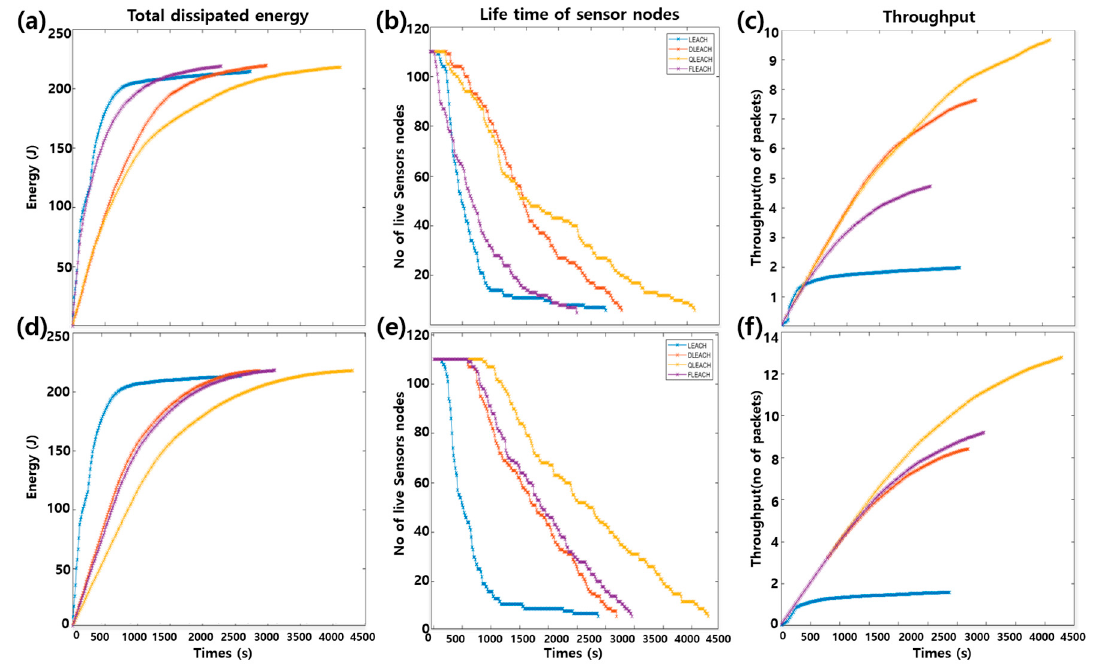
Figure 9. LEACH results on energy loss, number of alive nodes, throughput. ( a – c ) is the result from dynamic topology model and ( d – f ) is the result from static topology model.